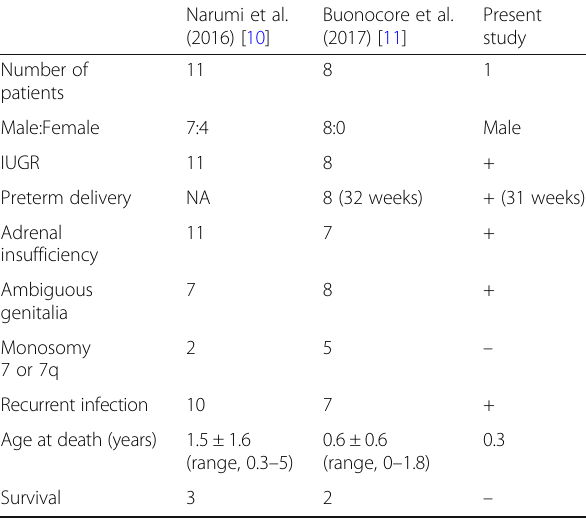
Table 1 Clinical characteristics of patients reported to have SAMD9 mutation and adrenal insufficiency